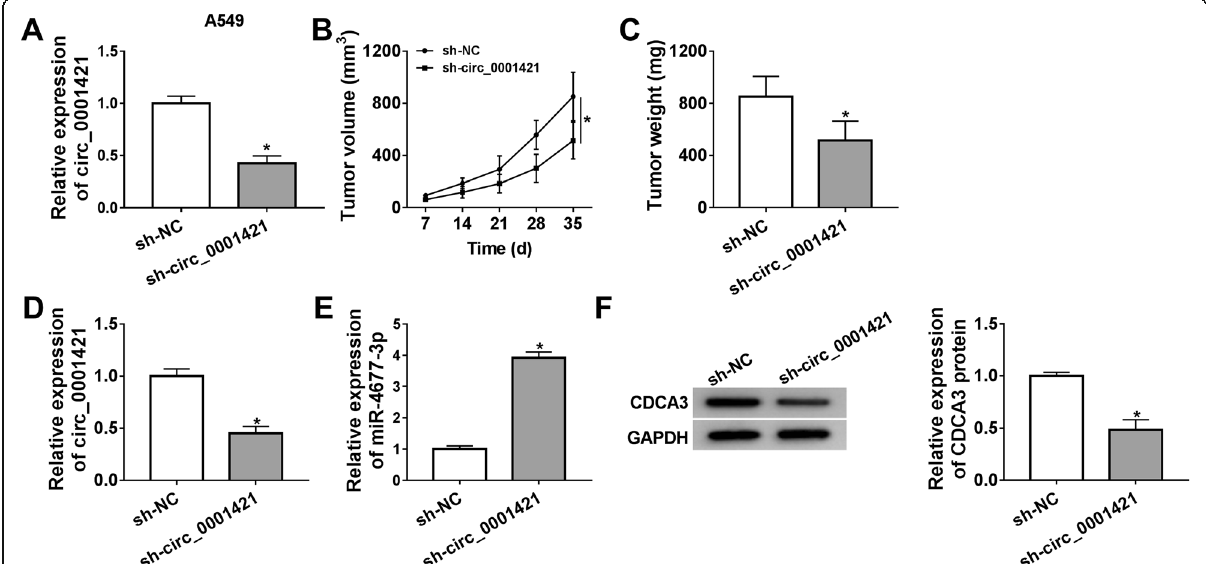
Fig. 7 Knockdown of circ_0001421 inhibited cell growth of LC cells in vivo. a The expression of circ_0001421 was detected by qRT-PCR in A549 cells. b-c The tumor volume and weight in the groups of sh-NC and sh-circ_0001421 were shown. d-e The expression levels of circ_0001421 and miR-4677-3p in that tumor were measured by qRT-PCR. f The protein of CDCA3 was examined by western blot. * P <